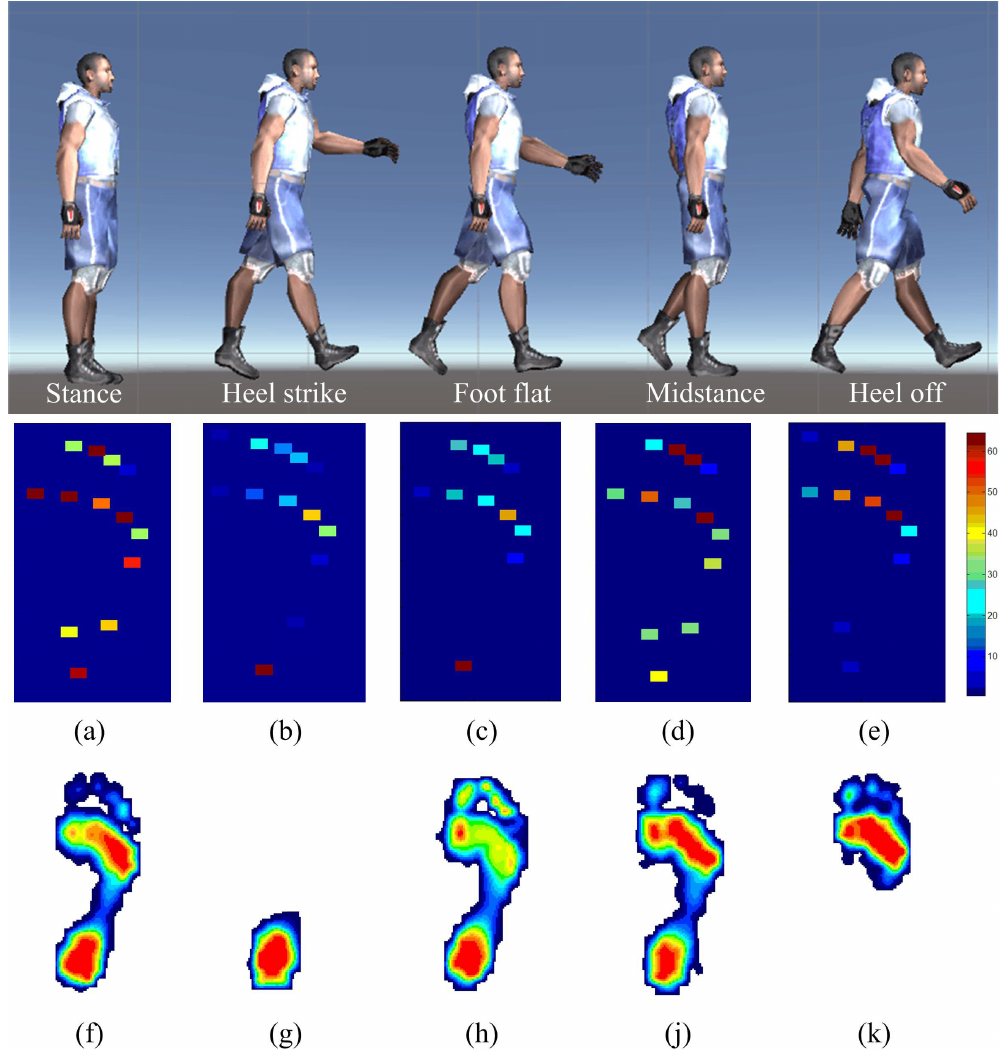
Figure 8. Plantar pressure distribution of right foot in the major phase of one full gait cycle. ( a – e ) images measured by our developed system. ( f – k ) images obtained by commercial pressure measurement